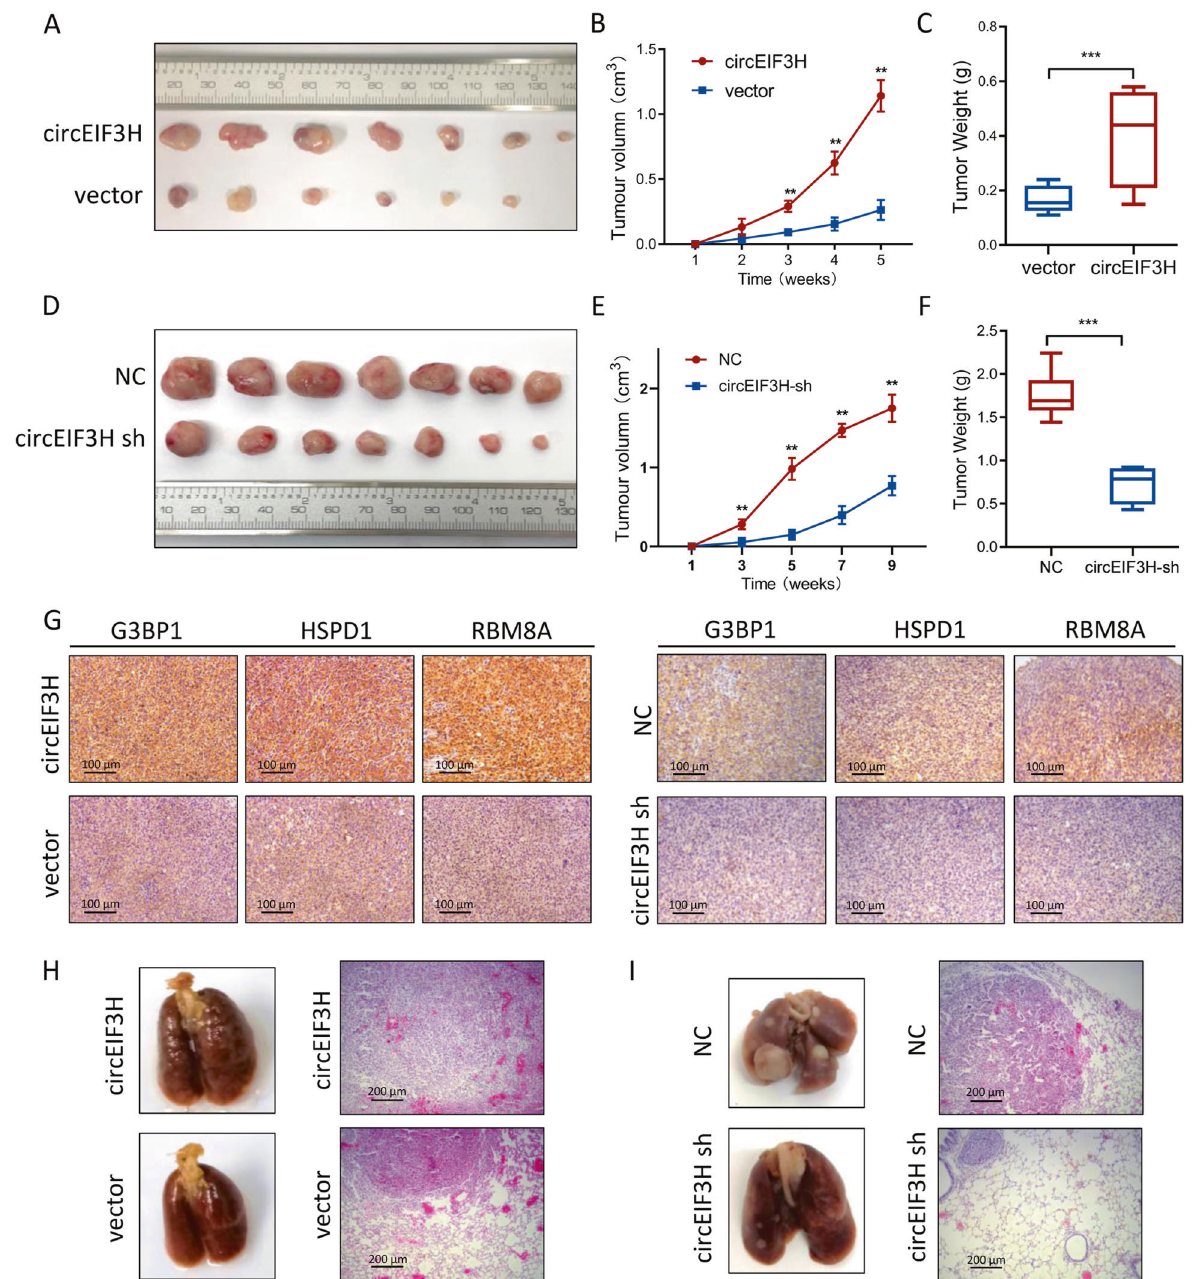
Fig. 6 CircEIF3H promotes tumor growth and metastasis in vivo. A MDA-MB-231 cells were stably transfected with the circEIF3H- overexpressing vector or control vector and injected subcutaneously into nude mice. CircEIF3H overexpression promoted tumor growth compared with the vector group. B , C Tumor growth rate ( B ) and tumor weight ( C ) of circEIF3H-overexpressing group and vector group were presented as mean ± SD; circEIF3H-overexpressing group n = 7; vector group n = 6; ** P < 0.01, *** P < 0.001. D MDA-MB-231 cells were stably transfected with the circEIF3H-sh vector or control vector and injected subcutaneously into nude mice. CircEIF3H-sh inhibited tumor growth compared with the vector group. E , F Tumor growth rate ( E ) and weight ( F ) were signi fi cantly decreased in the circEIF3H-sh group. Tumor growth rate ( E ) and tumor weight ( F ) of circEIF3H-sh group and NC group were presented as mean ± SD; n = 7; ** P < 0.01, *** P < 0.001. G IHC staining analysis of the expression of HSPD1, RBM8A, and G3BP1 in tumors. Scare bar = 100 μ m. H , I The macroscopic view of lung metastasis nodules and H&E-stained lung section images (Scare bar = 200 μ m) after tail vein injection of MDA-MB-231 cells with circEIF3H-overexpression or circEIF3H-sh ( n = 5). Statistical signi fi cance was determined by a two-sided Student ’ s t -test. both IGF2BP2 and HuR were previously reported as RNA-binding arrest via the formation of circ-Foxo3-p21-CDK2 ternary complex proteins for mRNA stabilization, we analyzed CLIP seq for both [23]. Therefore, we considered whether circEIF3H could bind to IGF2BP2 and HuR and found three target genes (HSPD1, RBM8A, some speci fi c protein and modulate the interactions and functions and G3BP1) among the overlapped parts. HSPD1, also called of these proteins. We found that circEIF3H could bind to IGF2BP2 HSP60, is essential for the folding and assembly of newly imported and HuR proteins, which were con fi rmed through RNA pull-down proteins in mitochondria. In addition, HSP60 is actively secreted by assay followed by mass spectrometry analysis and RIP assay. As Cell Death Discovery (2022)